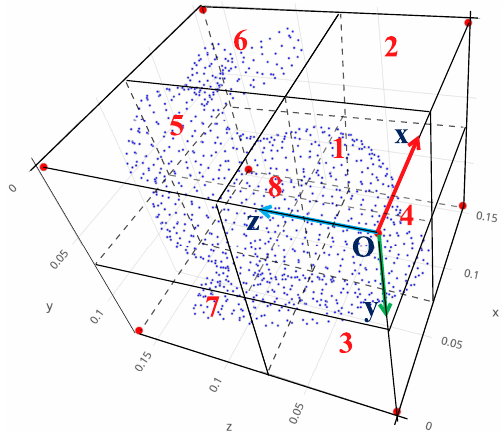
Figure 5. A demonstration of Axis-Aligned Bounding Box (AABB) divided into 8 sub-cubes.